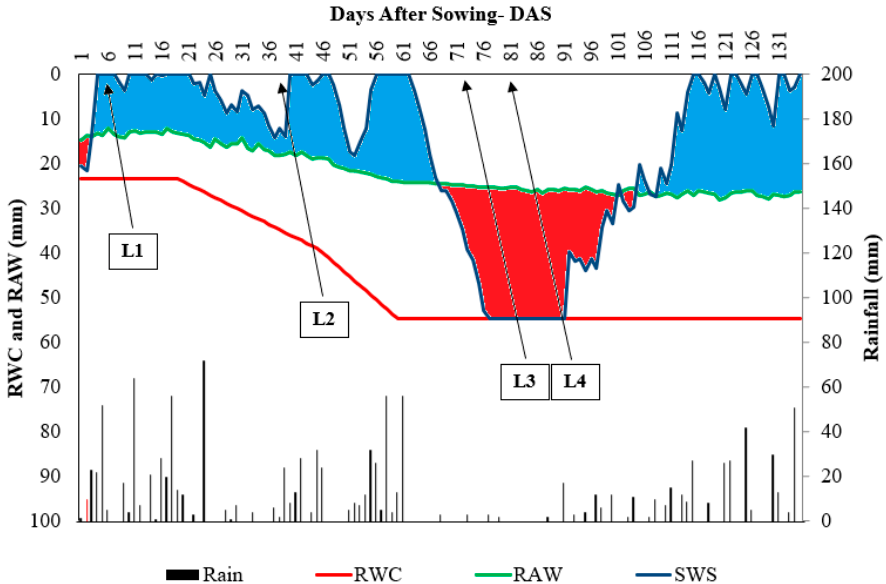
Figure 2. Soil water balance during soybean cultivation in rainfed conditions in a clayey soil of the Bra ‐ zilian Cerrado in the 2018/2019 season. RWC: Residual water content. RAW: readily available water. SWS: soil water storage. The arrows indicate the dates of the volumetric soil moisture readings (R). The volumetric soil moisture was measured using an electronic soil moisture meter, Hi ‐ drofarm model HFM 1010 (Falker ® ), at 0.20 m depth. Soil moisture readings (R) were per ‐